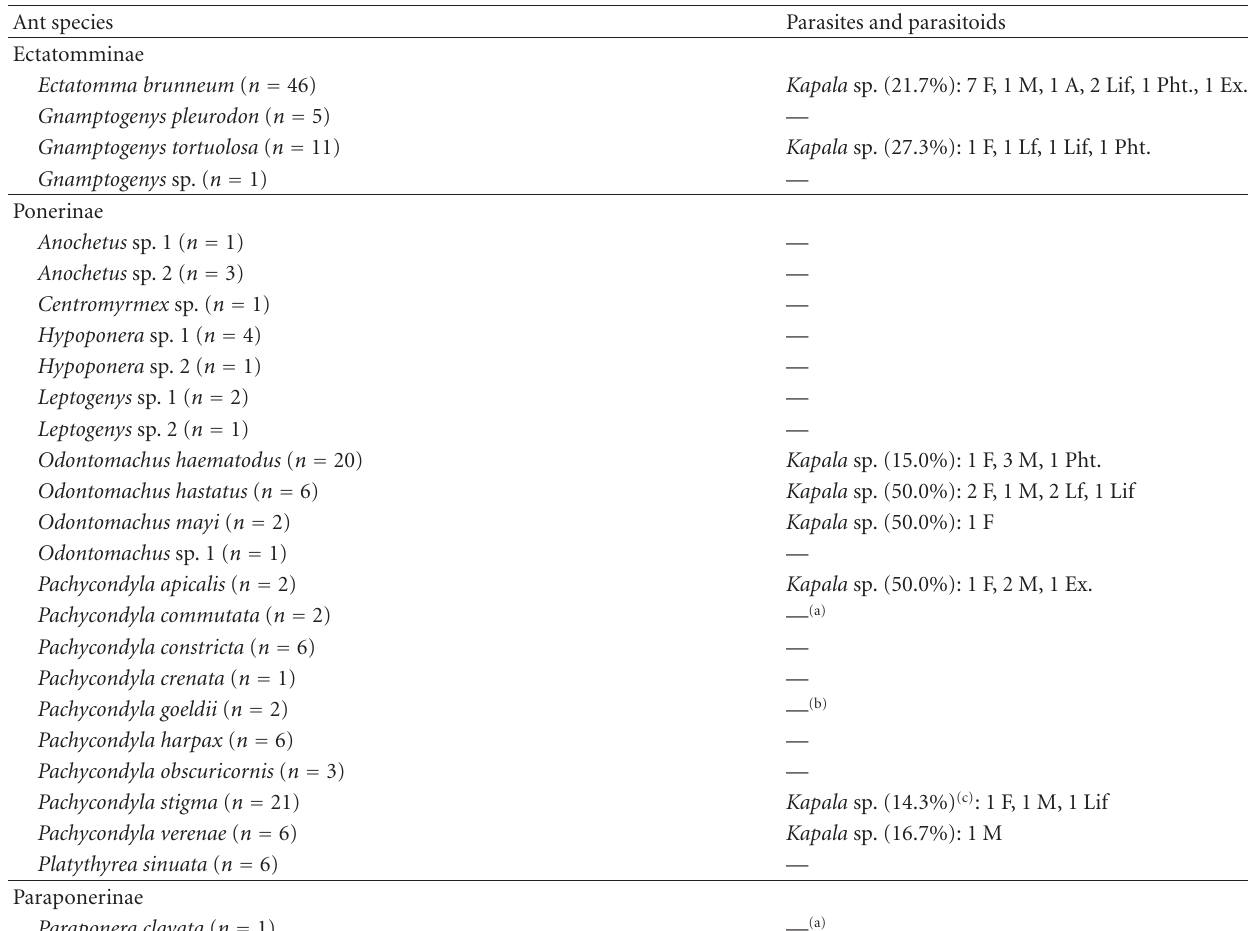
Table 1: Poneromorph ants of French Guiana and parasitism by Kapala . Ant species revised ( n = number of nests containing pupae), presence of eucharitid wasps, parasitism rate by eucharitids (in %), and number and developmental stage of specimens of Eucharitidae retrieved (F: female; M: male; A: adult, damaged specimen; Lif: first-instar larva feeding on host; Lf: last-instar larva; Pht.: phthisergate; Ex.: presence of eucharitid exuvia within an empty